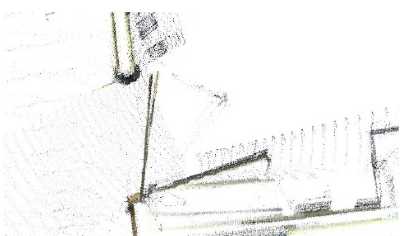
Figure 11. Some doors are scanned twice, both in open and closed positions, generating two line segments for the same